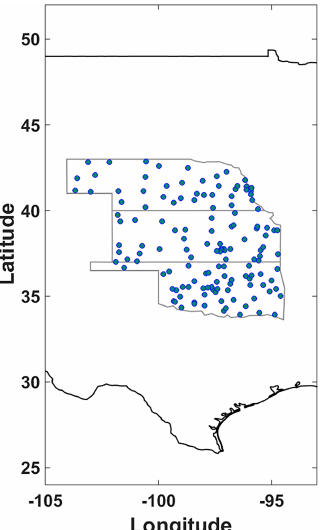
Figure A2. The ASOS ceilometer distribution over land used for CBH